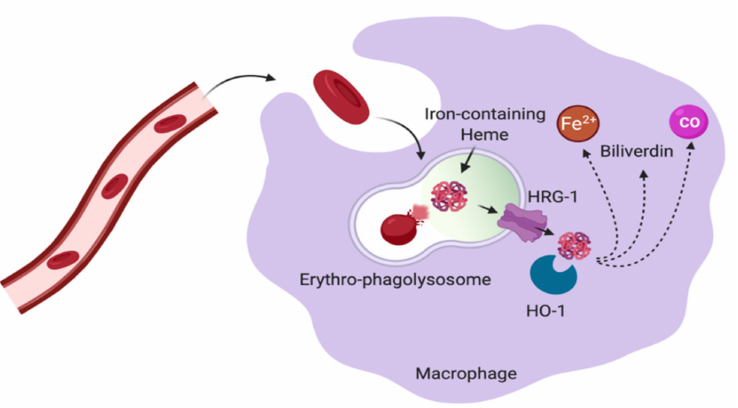
Figure 5. Erythrophagocytosis by macrophages. Macrophages in the red pulp of the spleen destroy senescent red blood cells and recycle the stored iron to be further incorporated into maturating RBCs during erythropoiesis. Senescent RBCs are engulfed into the phagolysosome of macrophages. Within the erythro-phagolysosome, RBCs are digested resulting in the breakdown of hemoglobin. Iron-containing heme is transported into the cytosol via HRG1. In the cytosol, iron bound to heme is processed by HO-1, resulting in the release of Fe 2+ , biliverdin and CO. The illustration was created using BioRender.com, (accessed on 3 April